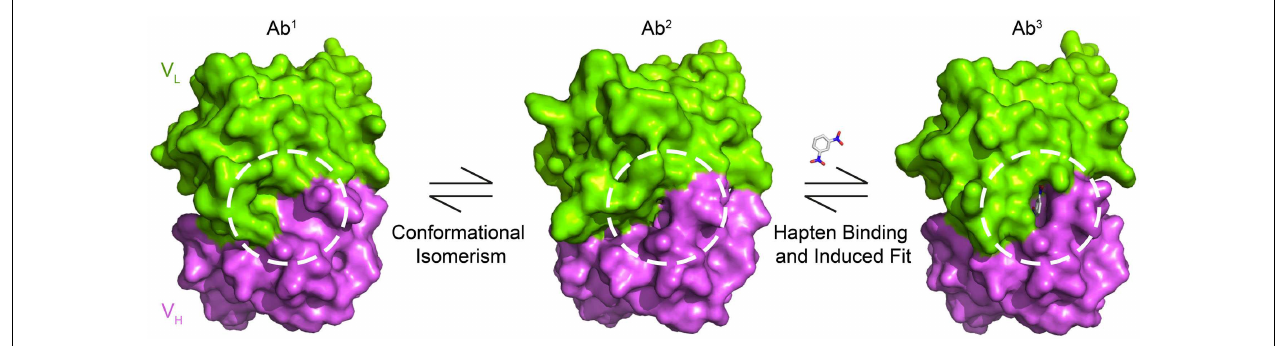
surface around the key CDRH3 pocket (dashed circle), the pocket is deep, and narrow for Ab 2 . After hapten binding to Ab 2 a further, induced-fit conformational change occurs resulting in the Ab 3 -hapten bound conformer (pdb: